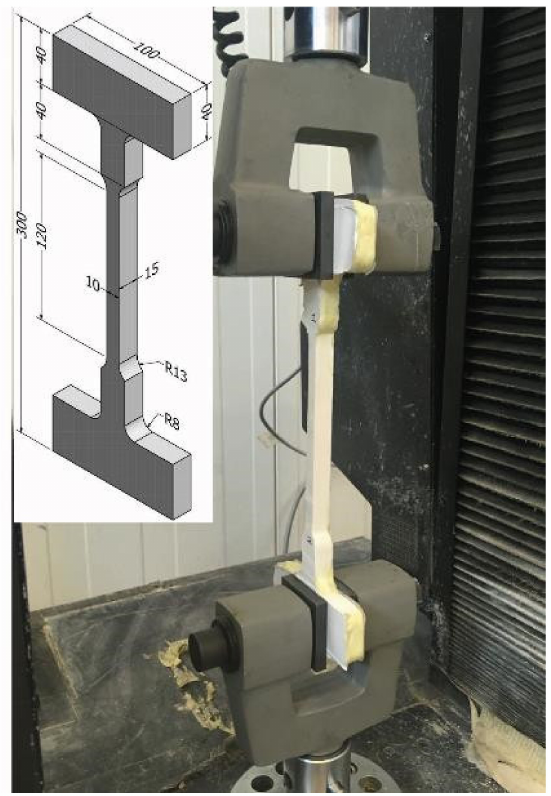
Figure 6. Injection of PU adhesive and related dog bone test specimen. Note: Units in mm. At least three specimens per adhesive were tested in tension at a load rate of 10 mm/min.